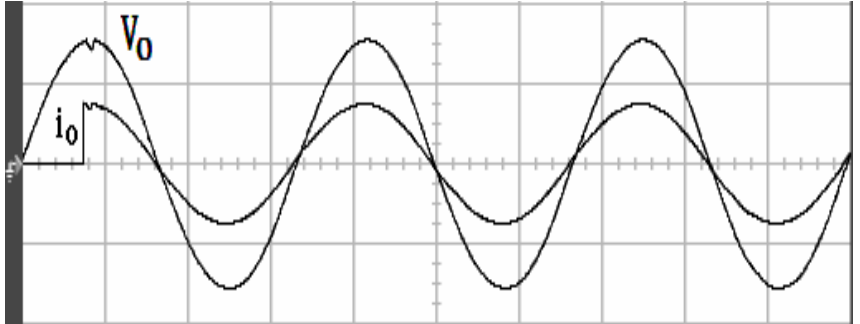
Figure 10. Output voltage and current for experiment of the proposed solution from no load to full load (vertical: 100 V/div and 20 A/div; horizontal: 5 ms/div).